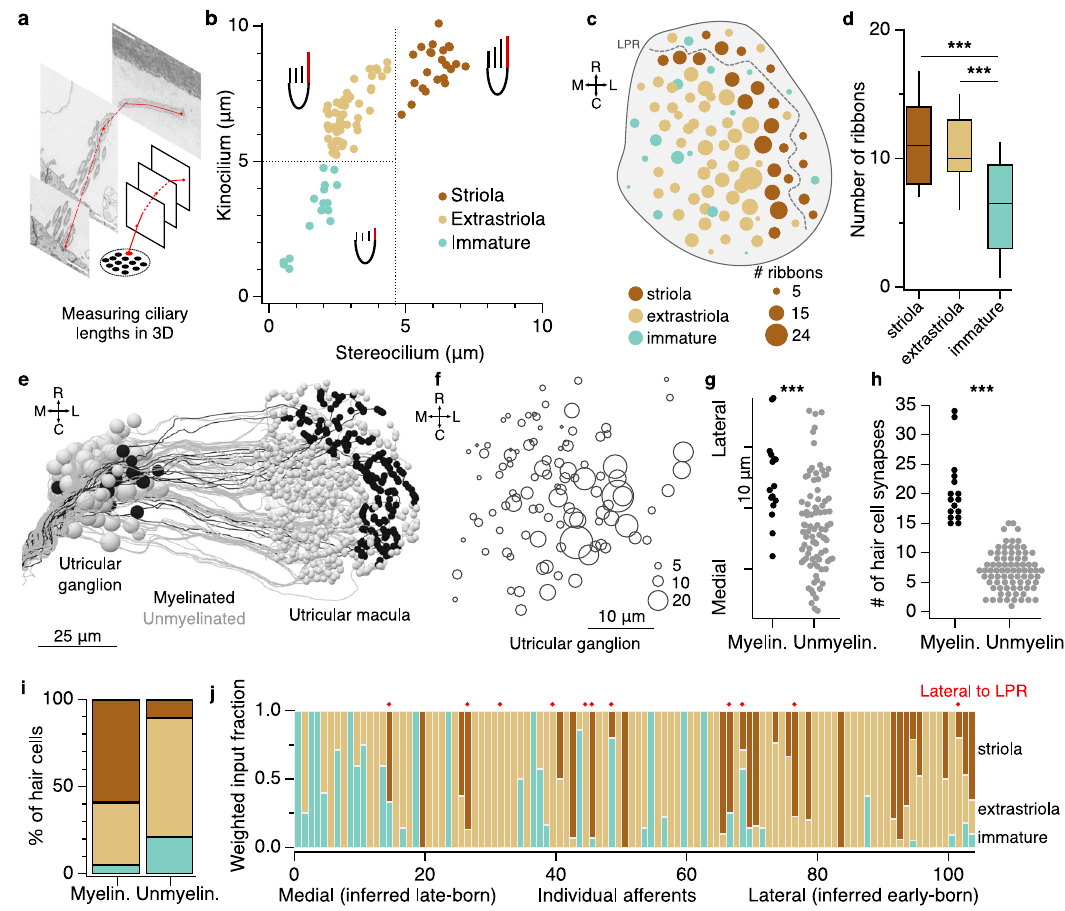
Fig. 5 | The utricular afferent ganglion is organized in the mediolateral axis by developmental sequence and temporal dynamics. a Representation of kino- cilium reconstruction across successive images to obtain the total length. The neighboring tallest stereocilium was also reconstructed (not schematized). b Plotof length of the kinocilium vs. the tallest stereocilium for all91 haircells. Striolar hair cells are identi fi ed by their long stereocilia and low K/S ratios, whereas extrastriolar hair cells have higher K/S ratios. Hair cells characterized as immature have short kinocilia and stereocilia. c Horizontal projection of the utricular macula, showing number of synaptic ribbons in each hair cell. Circle diameter re fl ects synaptic ribbon count; hair cells with larger numbers of ribbons tend to be located more centrally. See also Supplementary Fig. 1. d Quanti fi cation of synaptic ribbon counts across hair cell categories. Box plot represents medians ±25%ile; whiskers indicate 10-90%iles. Immature hair cells form fewer ribbon synapses than striolar or